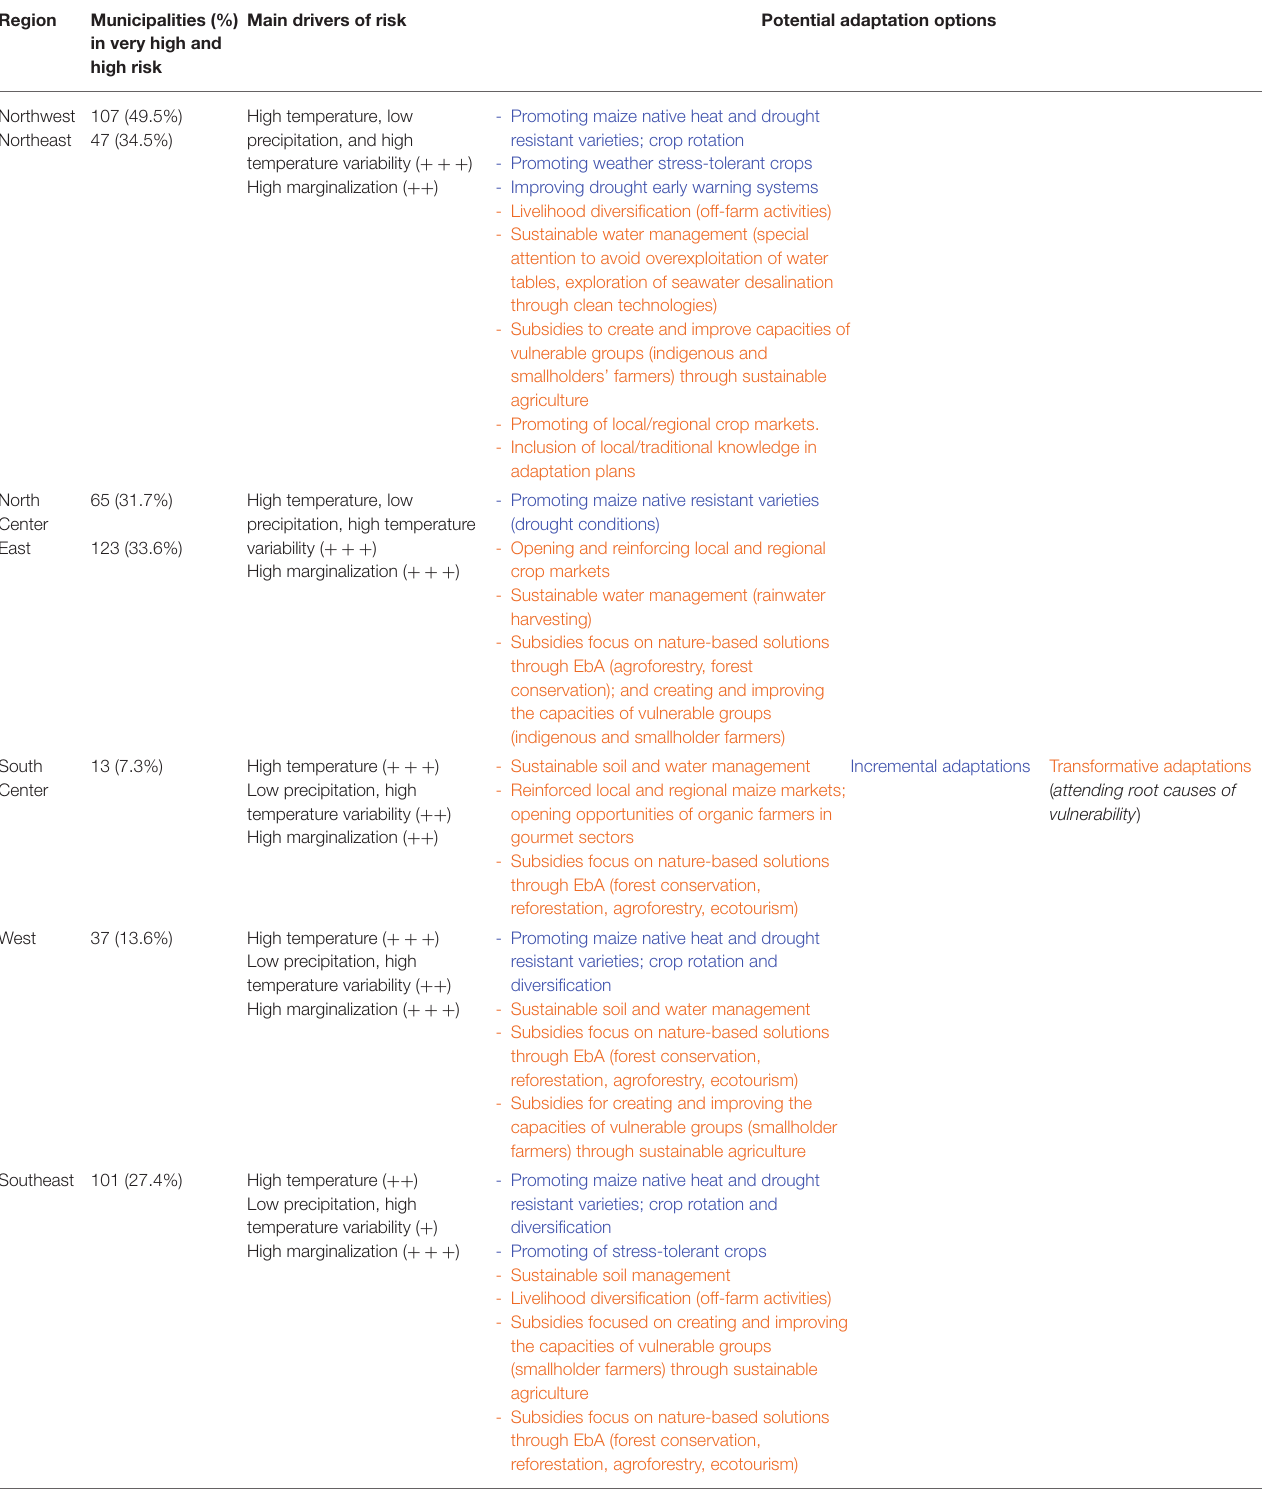
TABLE 6 | Municipalities in the category of very high-risk and high-risk, according to their regionalization. Region Municipalities (%) in very high